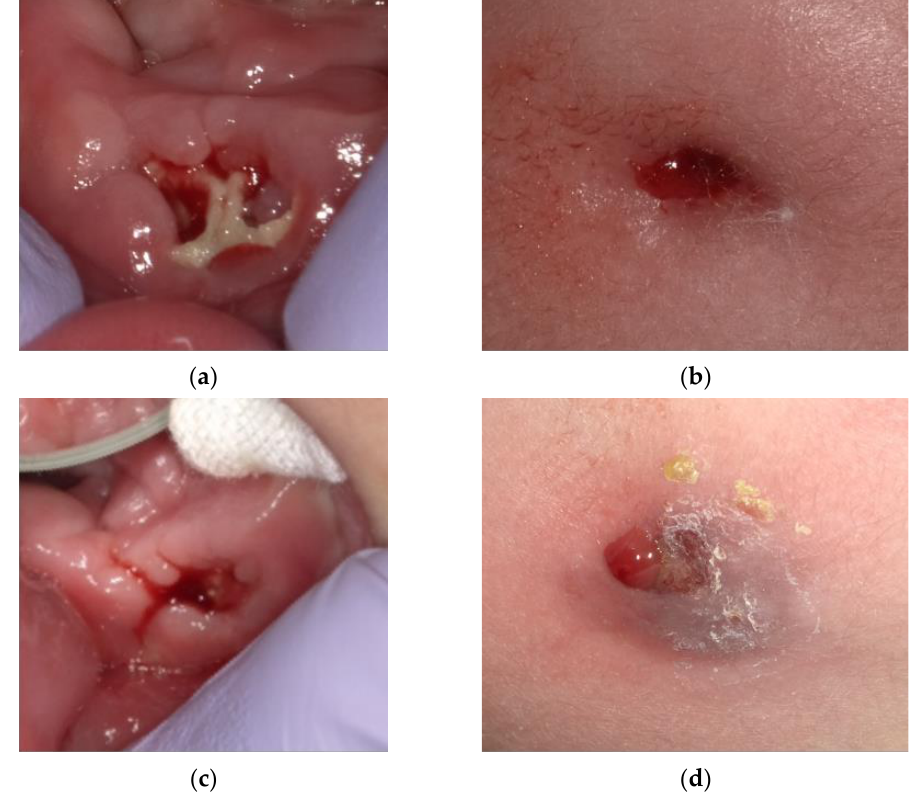
Figure 6. ( a , b ) Intra- and extraoral photographs acquired at the age of 5 years and 4 months. ( c , d ) Intra- and extraoral photographs acquired at the age of 5 years and 5 months.